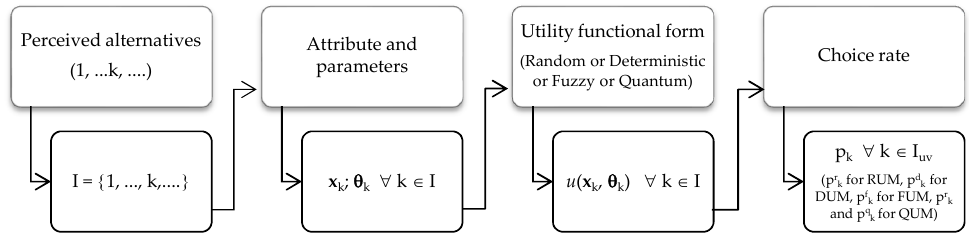
Figure 3. Path choice model: variables and parameters.